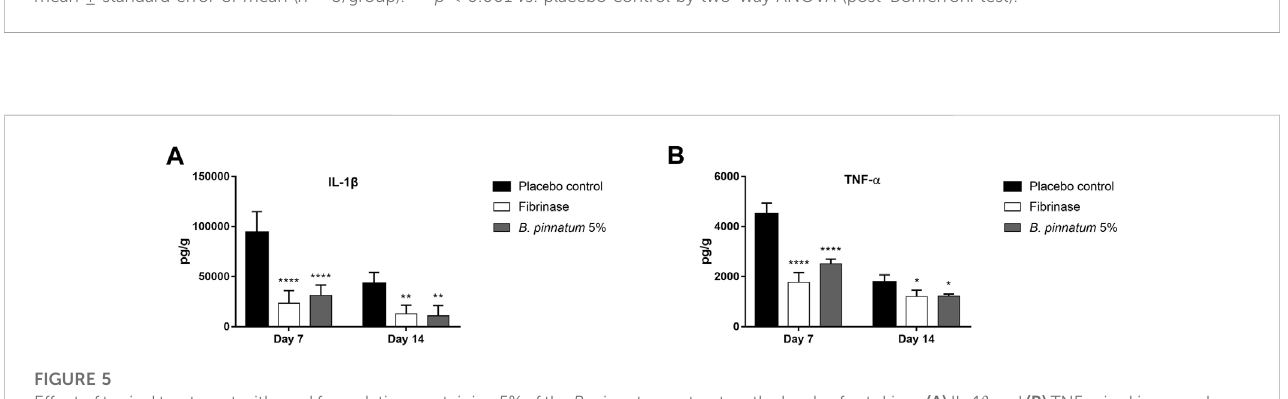
FIGURE 4 (A) Effect of topical treatment with a gel formulation containing B. pinnatum leaf extract at 5% on the skin wound area in rats. (B) Results expressed as mean ± standard error of mean ( n = 5/group). *** p < 0.001 vs . placebo control by two-way ANOVA (post-Bonferroni test).